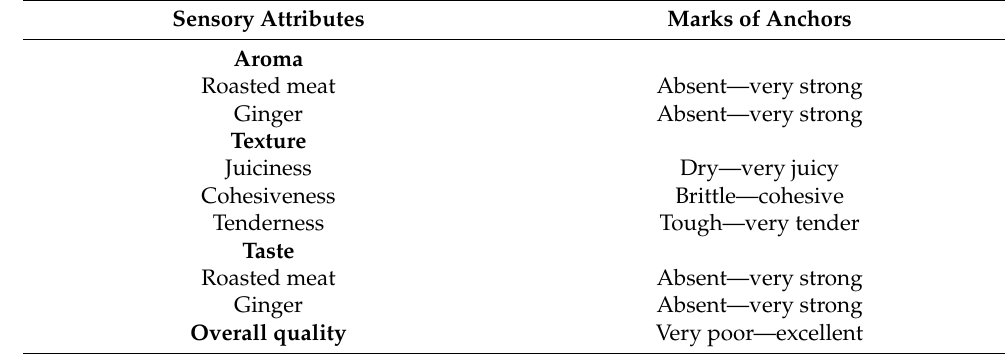
Table 1. Sensory attributes of pork